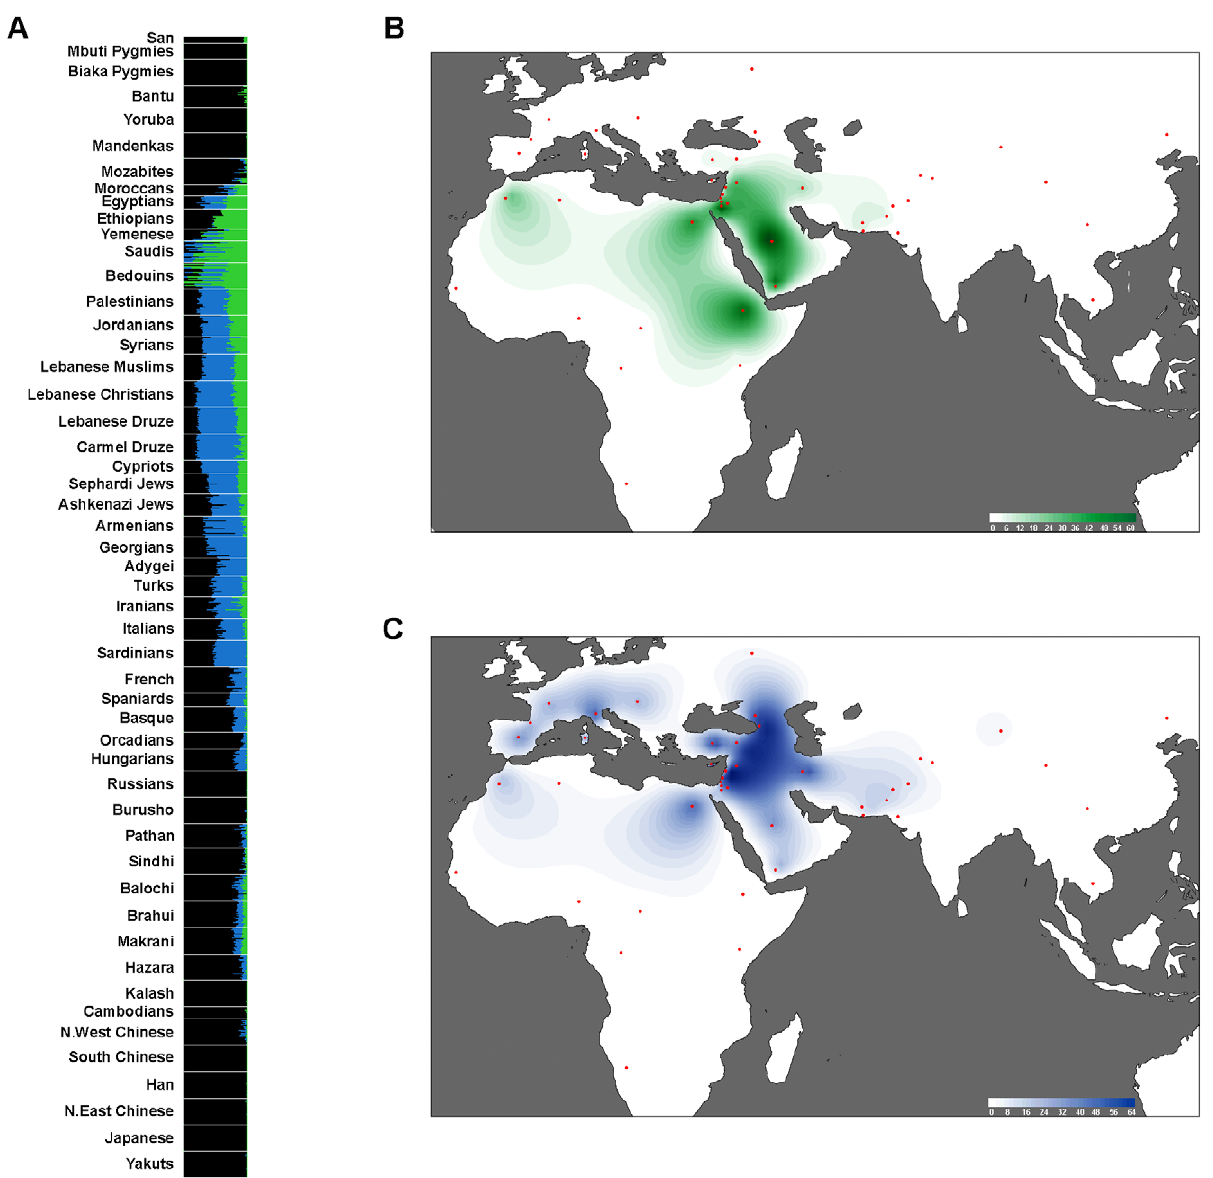
Figure 4. Comparisons of the Levantine and Middle Eastern modal components. A) ADMIXTURE analysis based on 10 constructed ancestral components, with only the Levantine and Middle Eastern components highlighted. B) Frequency of the Middle Eastern component in world populations. C) Frequency of the Levantine component in world populations. Intensity of the colors reflects the frequency of a component in the plotted populations. Maps were produced using a weighted average interpolating algorithm, and therefore should be used as a guide rather than a precise representation of the frequency distribution.